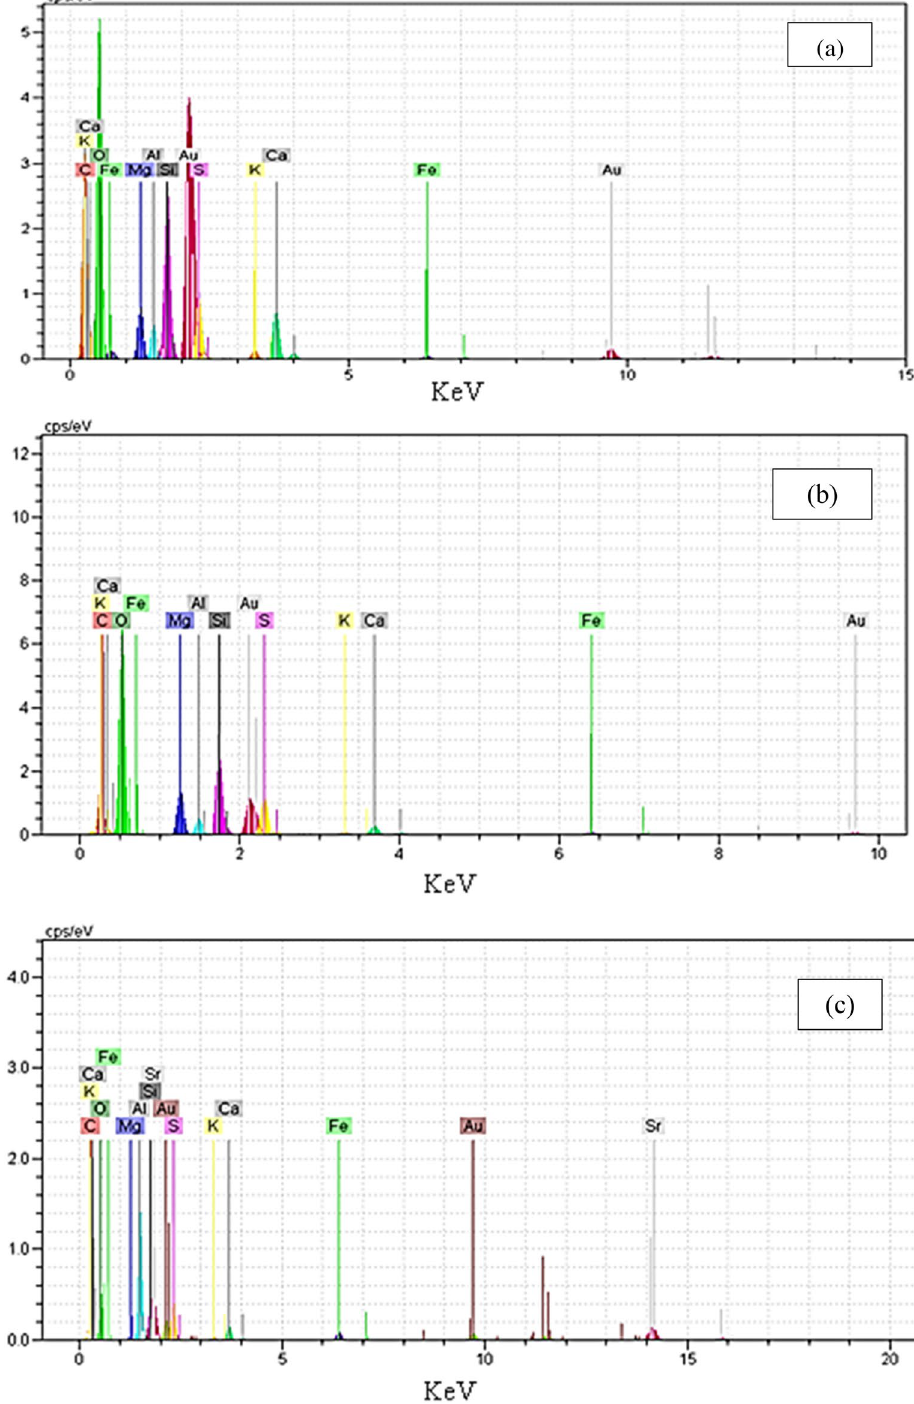
Figure 5. EDX analysis of sargassum sp. before ( a ) and after ( b ) Mg treatment, and after ( c ) strontium (II) sorption. Au peak comes from sample